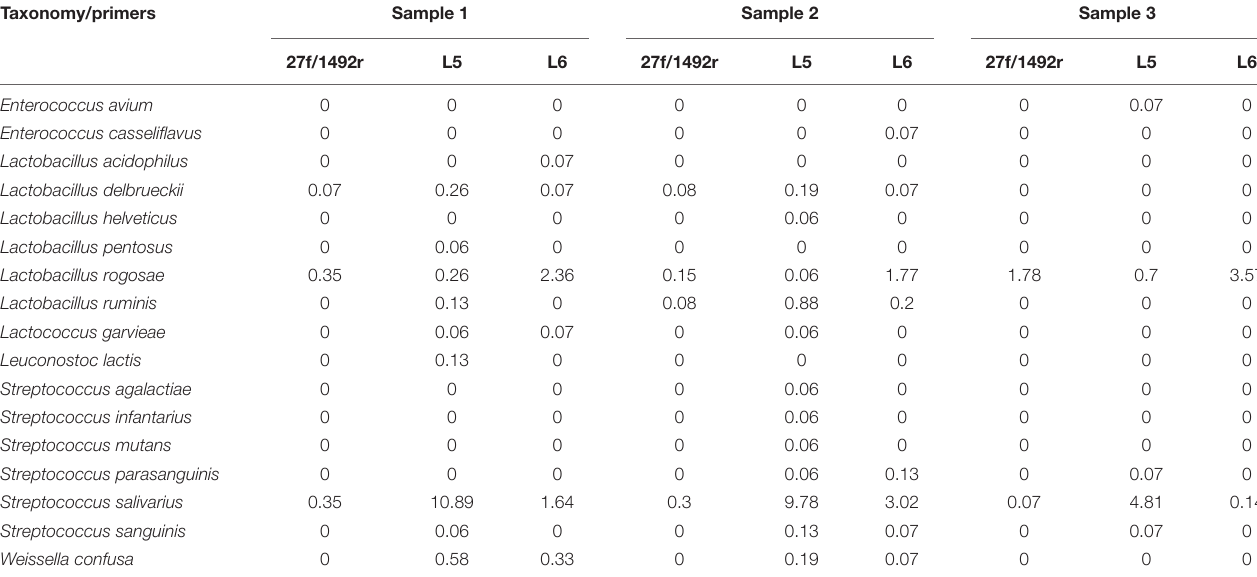
TABLE 4 | The relative proportion of LAB species identified from samples of feces by group-specific primers (%). Taxonomy/primers Sample